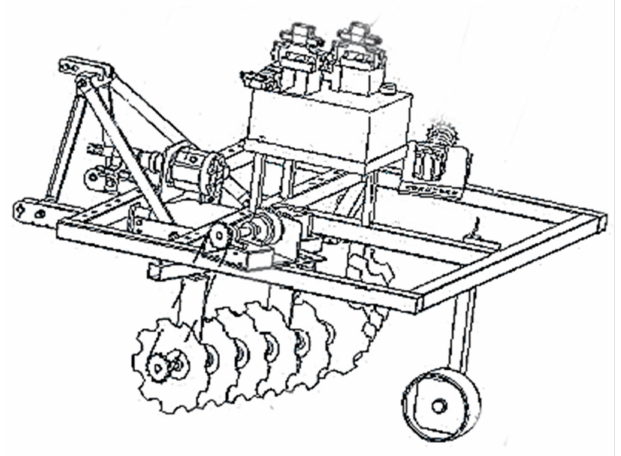
Figure 3. Hydraulic-driven disc harrow structure